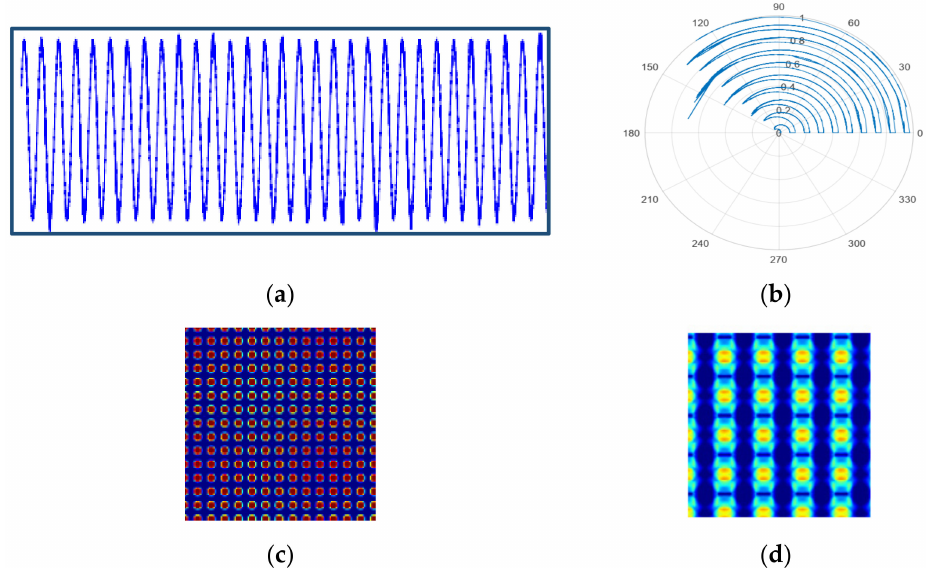
Figure 3. Steps of GAF: ( a ) normalized time-series signal; ( b ) converted signal in polar coordinates; ( c ) GASF; and ( d )